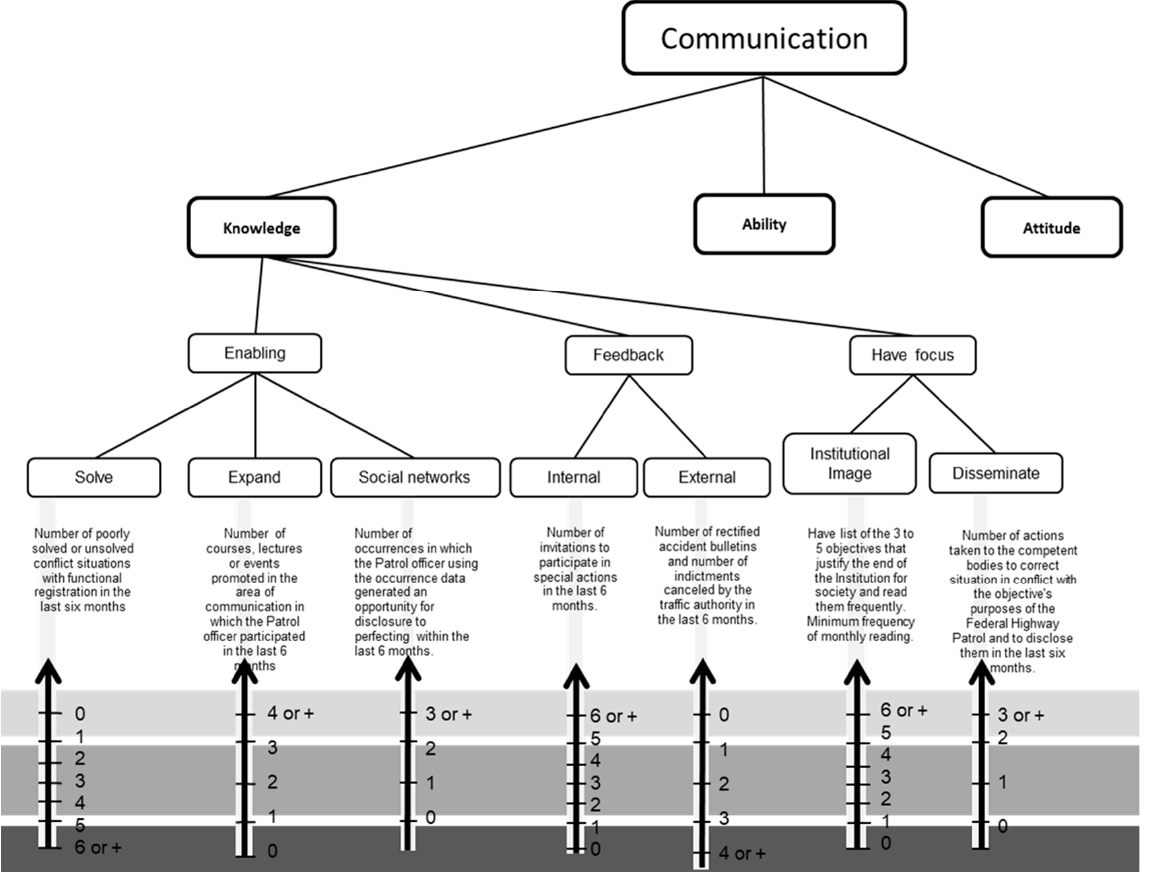
Figure 2. Descriptors with reference levels for PVE-Communication of FPV-Communication.